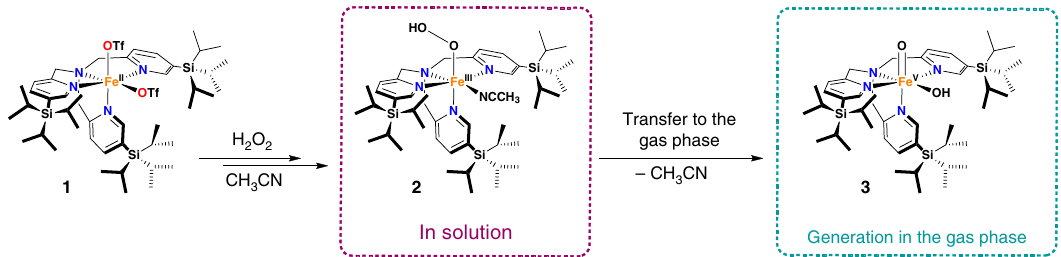
Fig. 2 Generation of the iron(V) intermediate 3 . Schematic diagram of the formation of ferric hydroperoxide species 2 in solution and subsequent